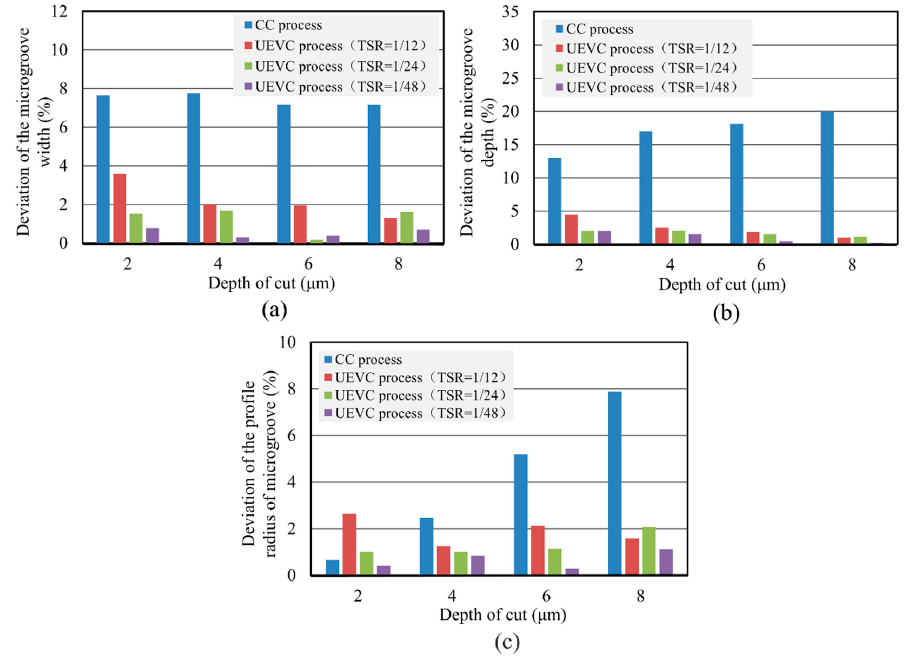
Figure 7. ( a ) Deviation of the micro-groove width, ( b ) deviation of the micro-groove depth, and ( c ) deviation of the profile radius of micro-groove.